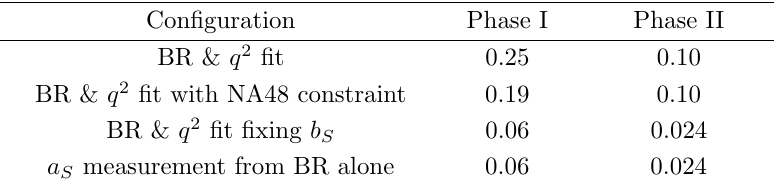
S under various analysis